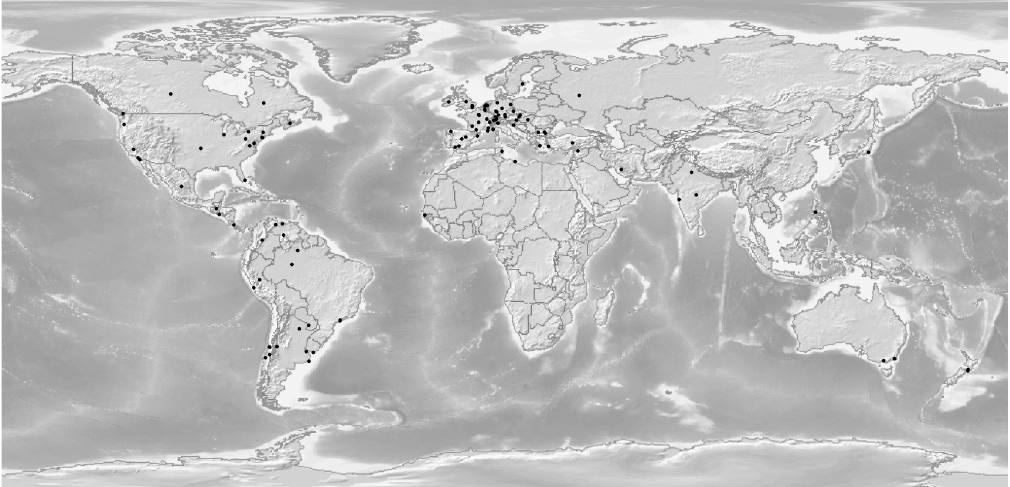
Fig. 4. Geographical localisation of the senders from abroad of letters to